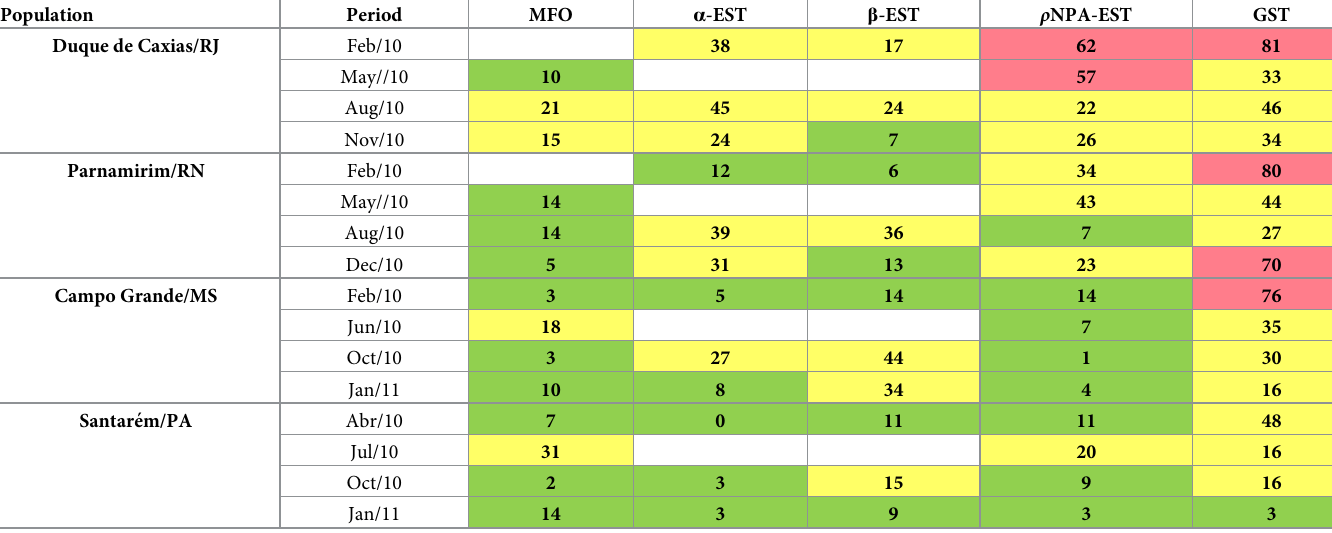
According to criteria defined previously [35, 36], enzyme activities were classified as unaltered (green), altered (yellow) and extremely altered (pink) if the rate of individuals above the 99 percentile for Rockefeller strain was below 15, between 15 and 50 and above 50%,